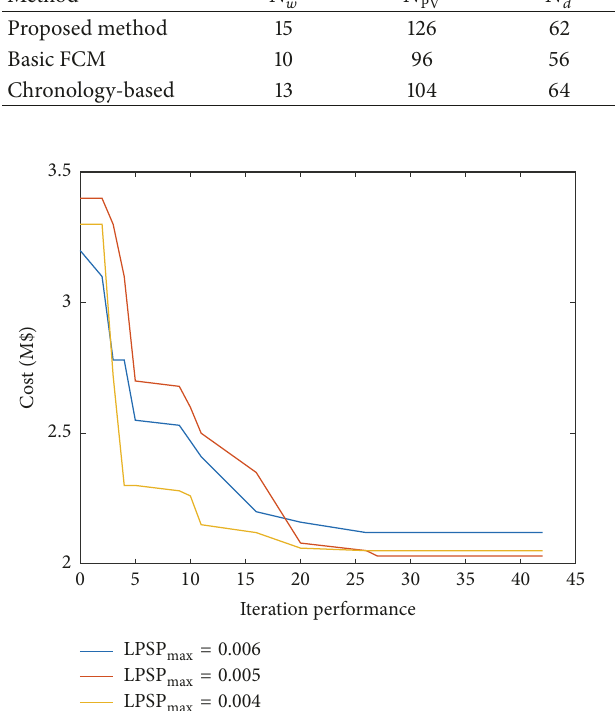
Figure 10: Sensitivity analysis of LPSP max and